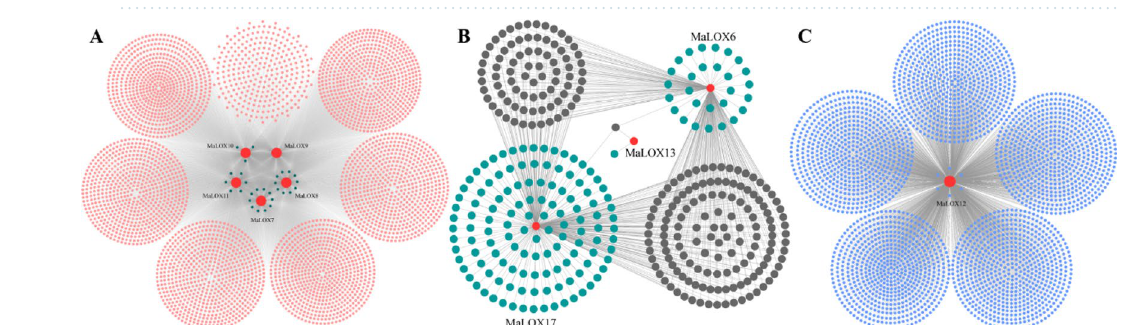
Figure 11. Expression analysis of MaLOX genes after Foc TR4 treatment. Uppercase and lowercase letters are used to indicate significantly differences at P < 0.01 and 0.05, respectively.